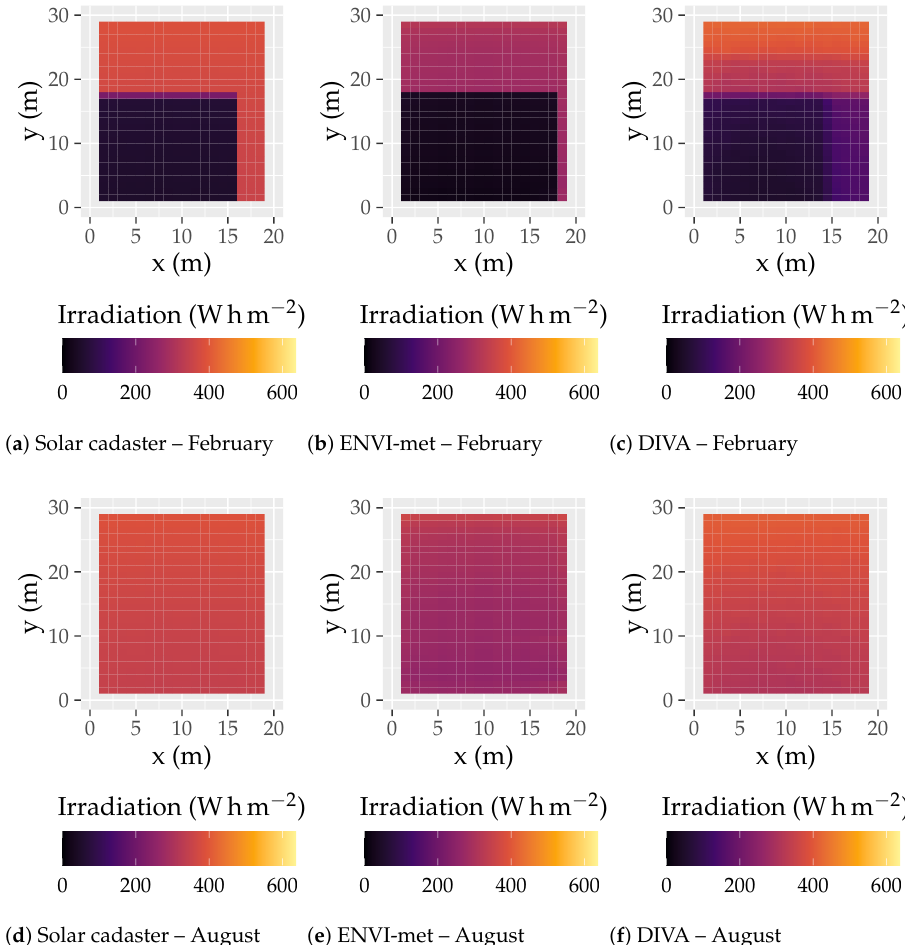
Figure 17. Irradiance map—Homogeneous district—South facade—12 h.